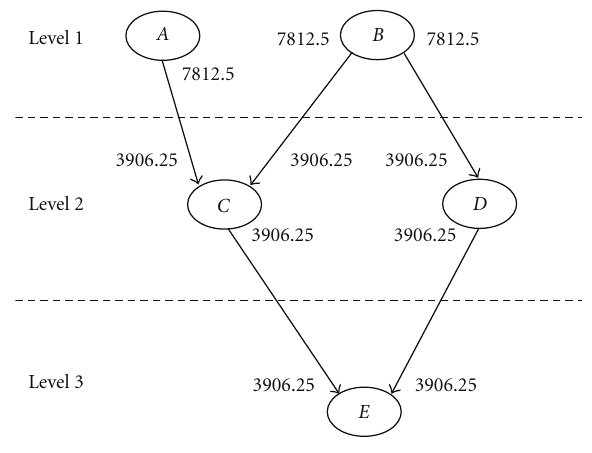
Figure 8: Tasks in the